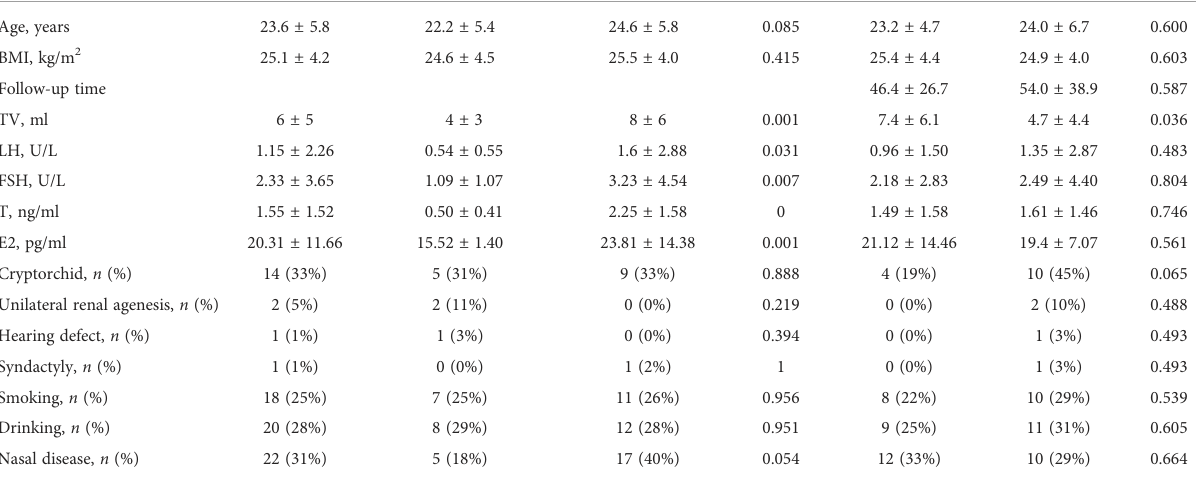
TABLE 1 Baseline clinical characteristics of the included CHH patients.